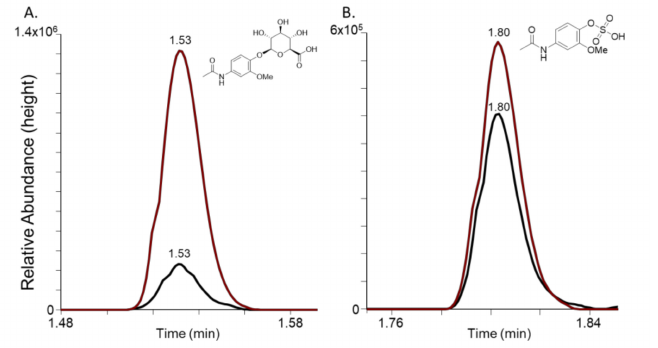
Figure 3. Co-elution of 3-methoxyacetaminophen metabolites (red) with peaks detected in human EDTA plasma (black). ( A ) Extracted Ion Chromatogram (XIC) of m / z 356.0987 +/ − 5 ppm in negative ion mode for 3-methoxyacetaminophen glucuronide (red) and human EDTA plasma (black); and ( B ) XIC of m / z 260.02343 +/ − 5 ppm in negative ion mode for 3-methoxyacetaminophen sulfate (red) and human EDTA plasma